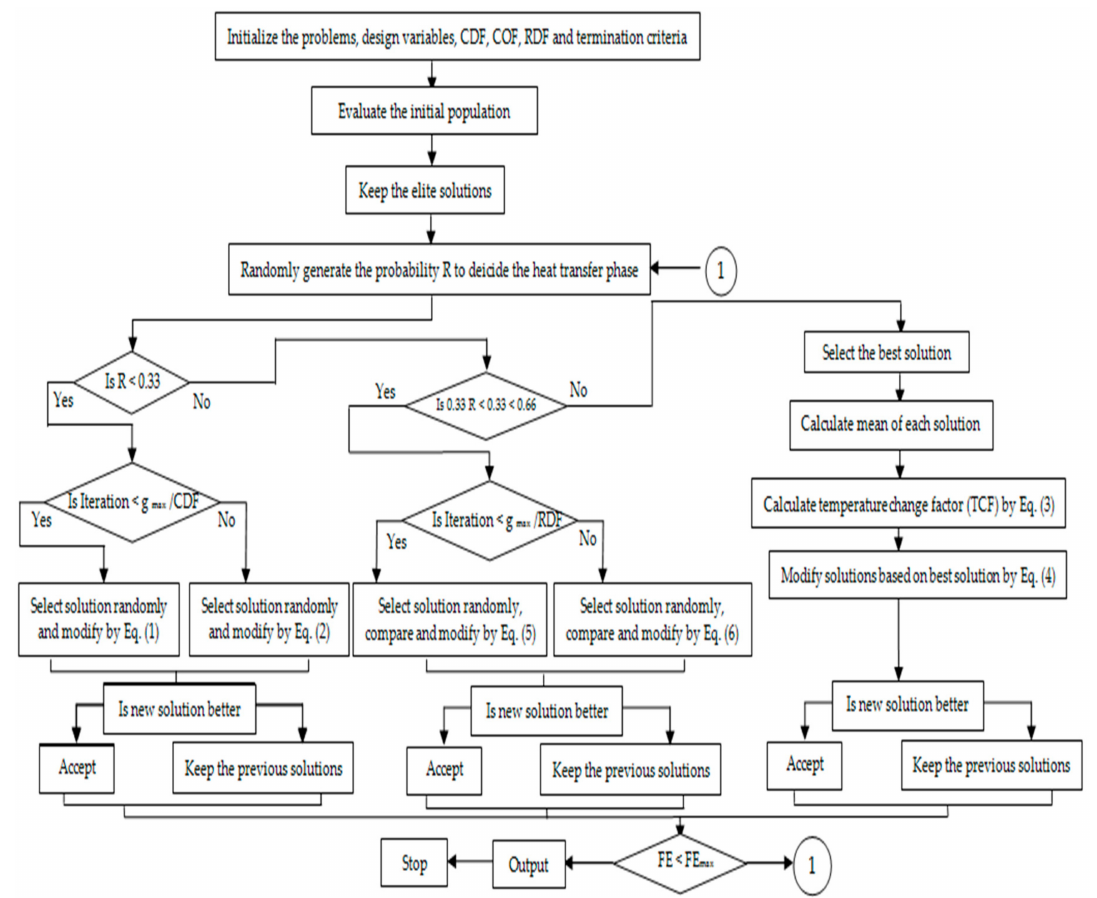
Figure 1. Flow chart of the heat transfer search (HTS)